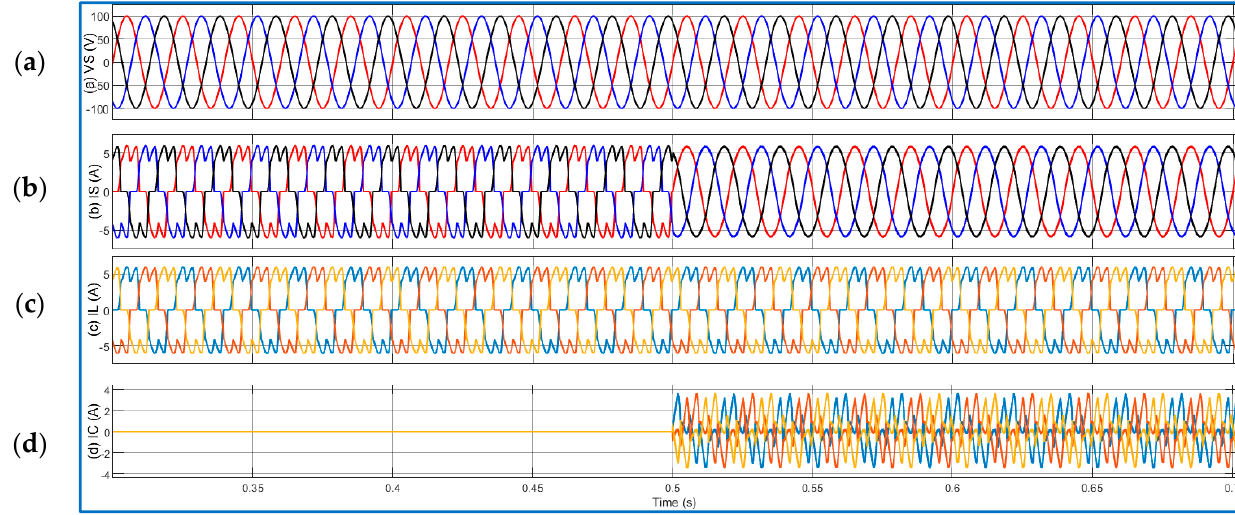
Figure 12. Three phase: ( a ) VS: supply voltage; ( b ) IS: supply current; ( c ) IL: Load current; ( d ) IC: compensator current.